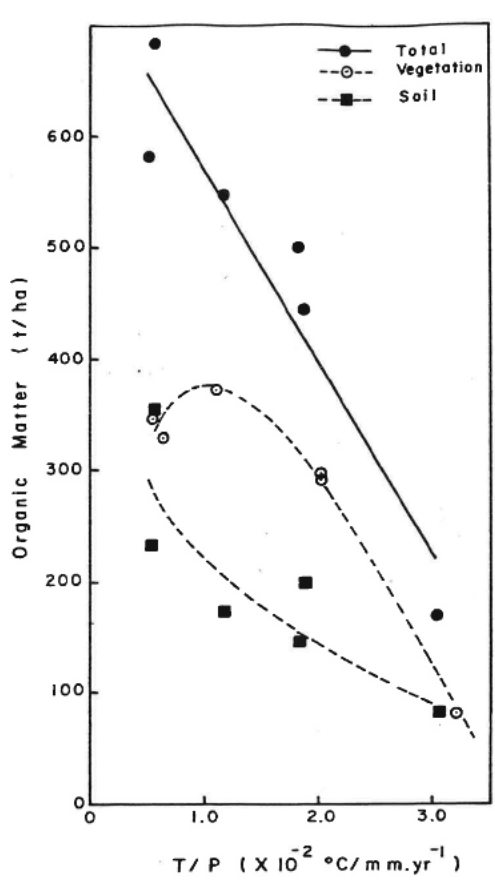
Figure 2. Relationship between aboveground and soil organic matter of mature tropical forests and the ratio of mean annual temperature to mean annual precipitation (T/P) [3].